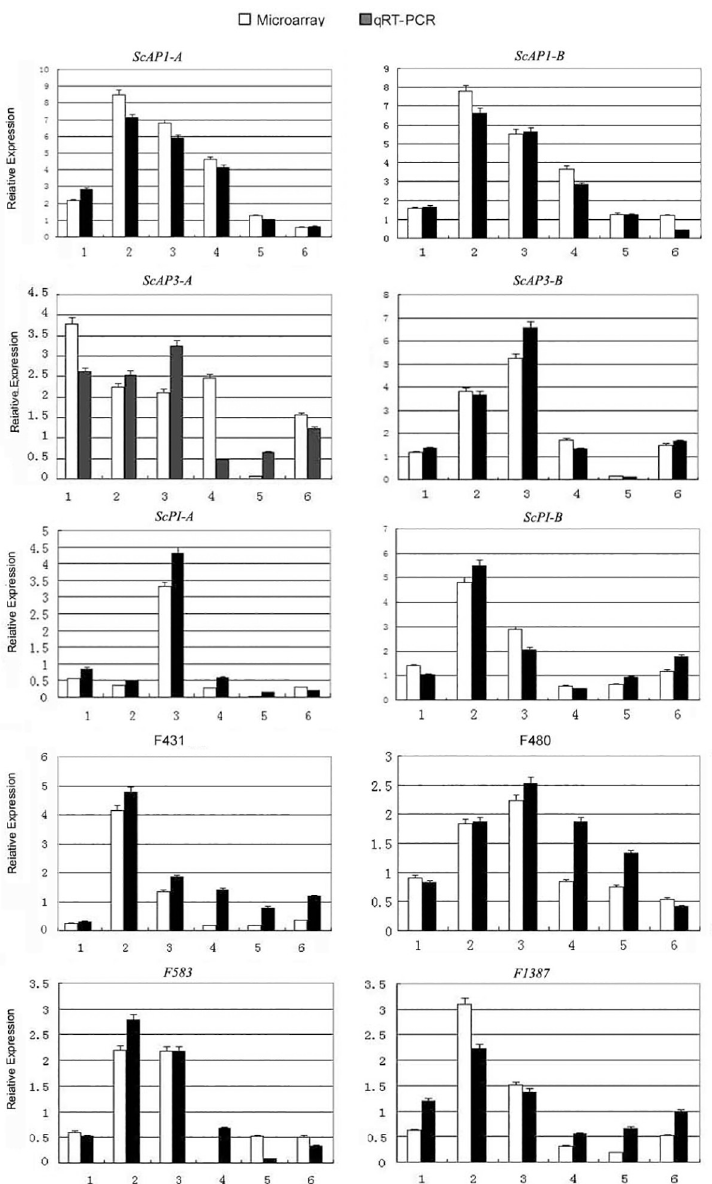
Fig 6. Validation of microarray results by qRT-PCR for selected genes. ScAP1-A and ScAP1-B MADS-box genes are F1254 and AY057378; ScAP3-A and ScAP3-B MADS-box genes are EH662329 and EG530709; ScPI-A and ScPI-B MADS-box genes are EG530711 and D658; the transcription factors are F431, F480, F583 and F1387. α -TUBULIN (JK704891) was used as an internal control for normalization of the template cDNA. Each sample was done in triplicate, and the error bars represent the standard deviation of the three independent experiments. In each graph, the white bars represent the relative expression found in the microarray experiments, and the black bars represent the relative expression determined by normalized qRT-PCR. The number 1 to 6 correspond in the X axis represent the half green and half white during the transition of green to white bracts, the fully white, as well as the stages following floral senescence the half green and half white during the transition of white to green bracts, and Fully pale green bracts when bracts are reverting back to green coloration.